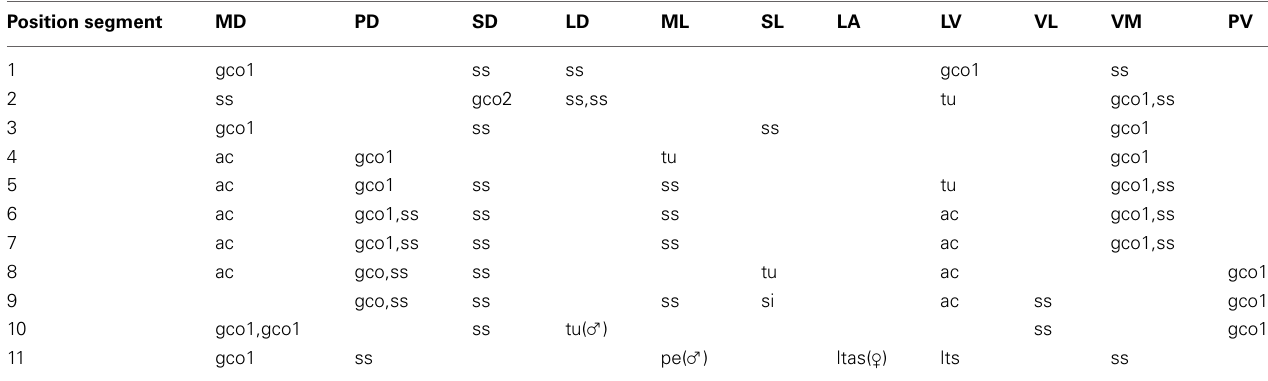
Table 3 | Summary of nature and location of sensory spots, glandular cell outlets, tubes and spines arranged by series in Echinoderes augustae sp.